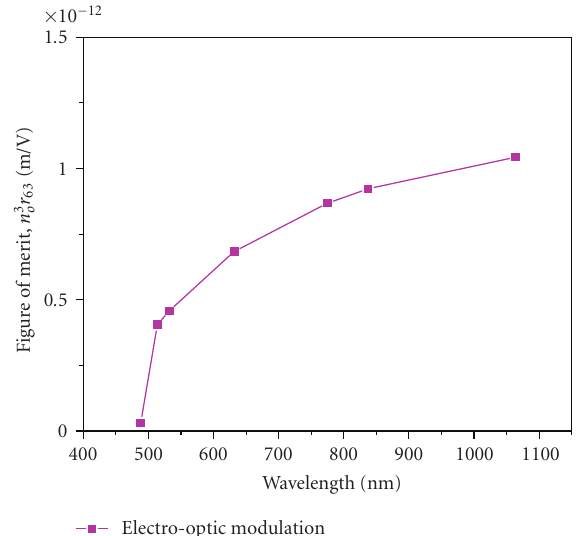
Figure 38: Wavelength versus Figure of Merit of EO modulation.